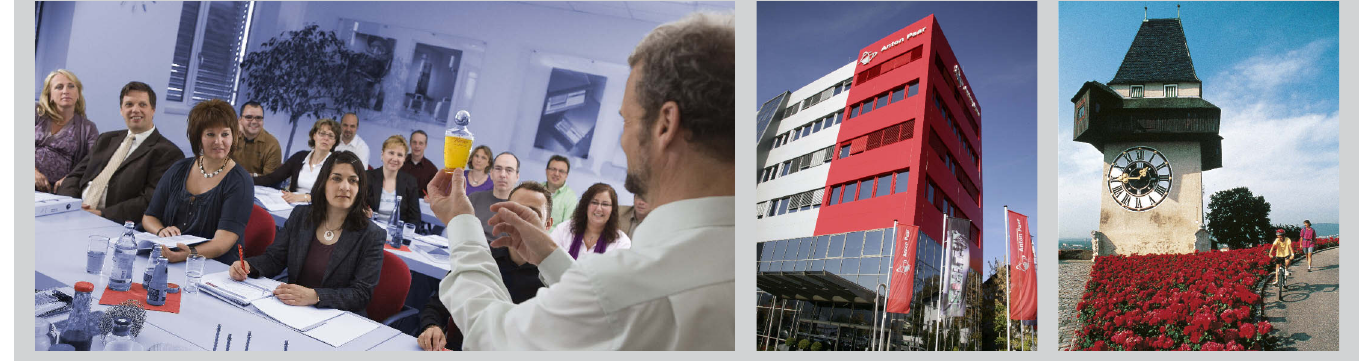
Figure 1 (page 303): Attendees of the “Basics of Rheology Workshop” held in Graz in June 2011. Figure 2 (left): Typical seminar situation. Figure 3 (middle): The seminar took place at the headquarters of Anton Paar in Graz. Figure 4 (right): Sightseeing in Graz: The